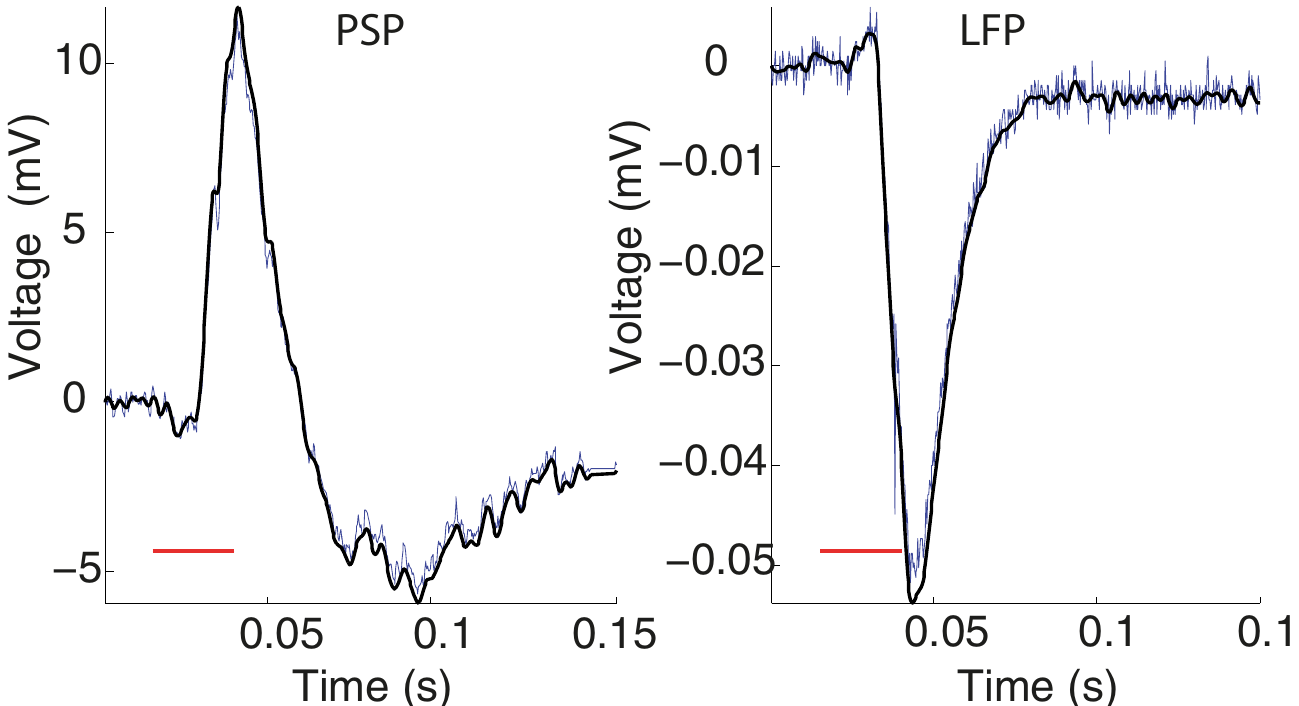
Fig 3. Filtering. PSP and LFP registers with and without low-pass filtering, 300Hz (black and blue curves, respectively). Examples from cell 13 (030201md03b) in response to 5527Hz. Electric potential relative to baseline, mean potential in first 15ms. Red trace indicates stimulus presentation.